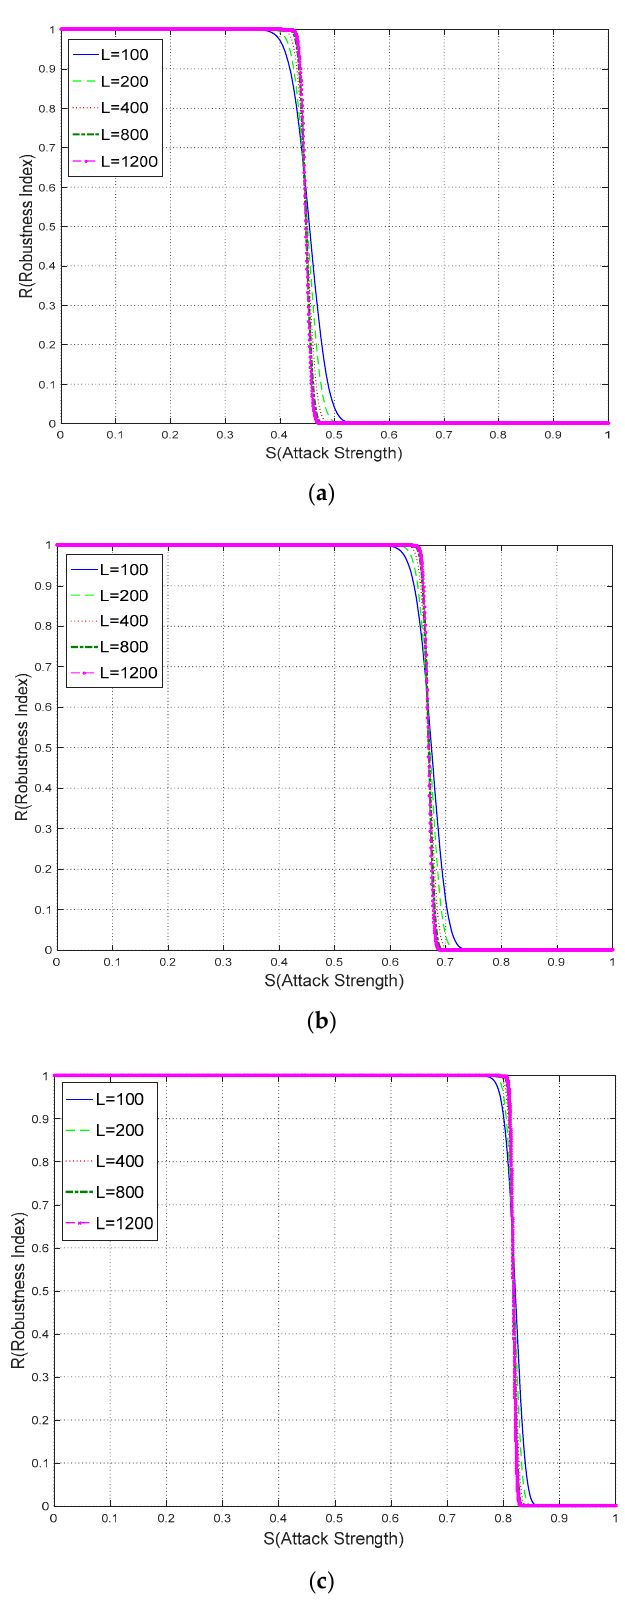
Figure 18. The relationship between robustness and watermark information length: ( a ) N = 2; ( b ) N = 4; ( c ) N = 8.